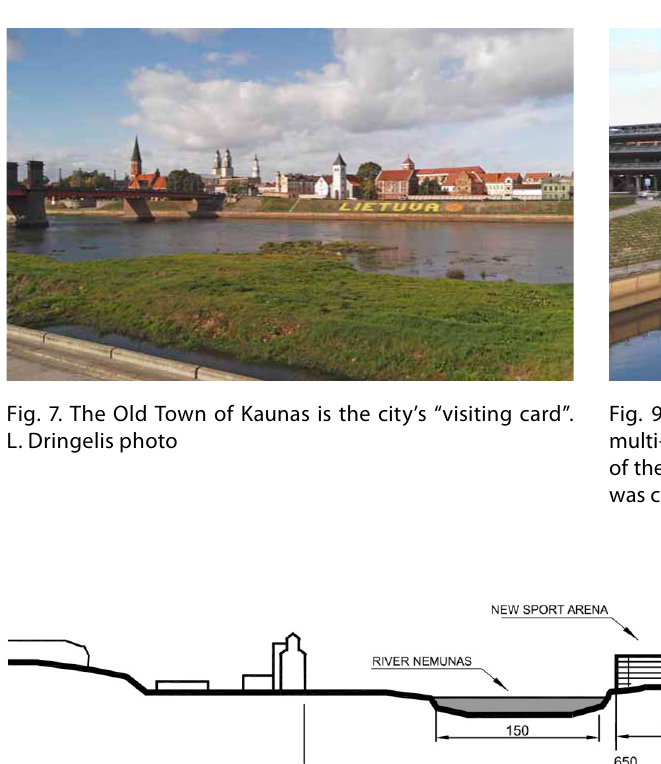
photofig. 8. The formation of King Mindaugas avenue in the city of Kaunas in the middle of the 20 th century. l. Dringelis